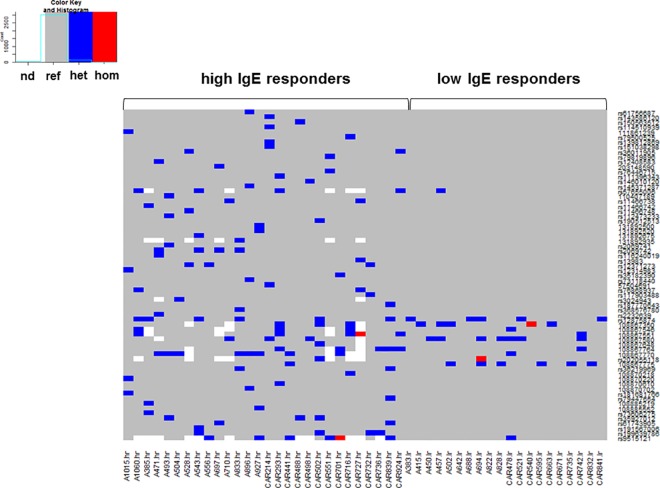
Burden of 70 single nucleotide variants with differential enrichment between high (≥75th percentile) and low (≤25th percentile) IgE responders to Ascaris and ABA-1.Each column corresponds to the pattern of one individual. The color scale indicates the reference genotype (grey) or the presence of single nucleotide variants in heterozygous (blue) or homozygous (red).